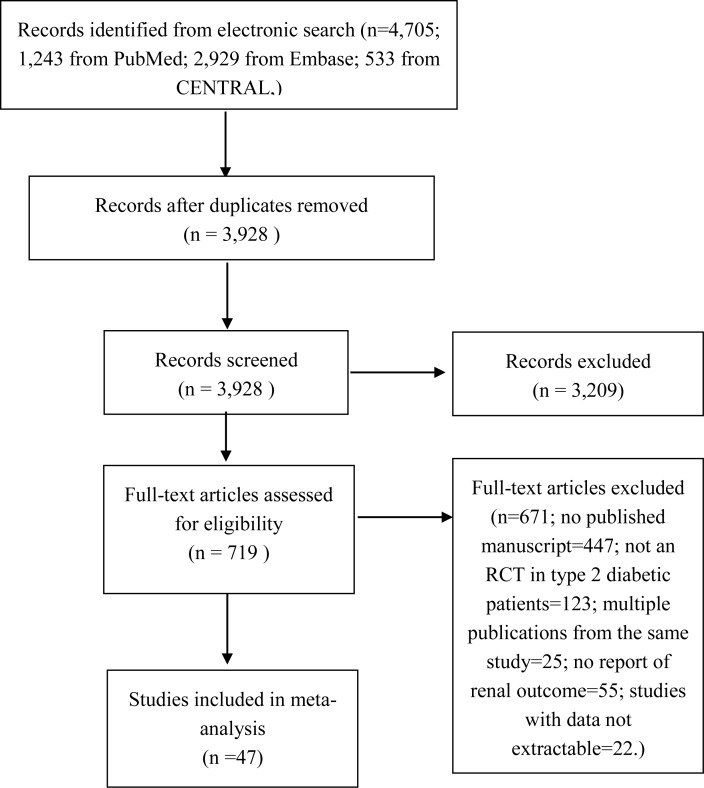
Identification process for eligible studies.Abbreviations: CENTRAL, Cochrane Central Register of Controlled Trials; RCT, randomized controlled trial.